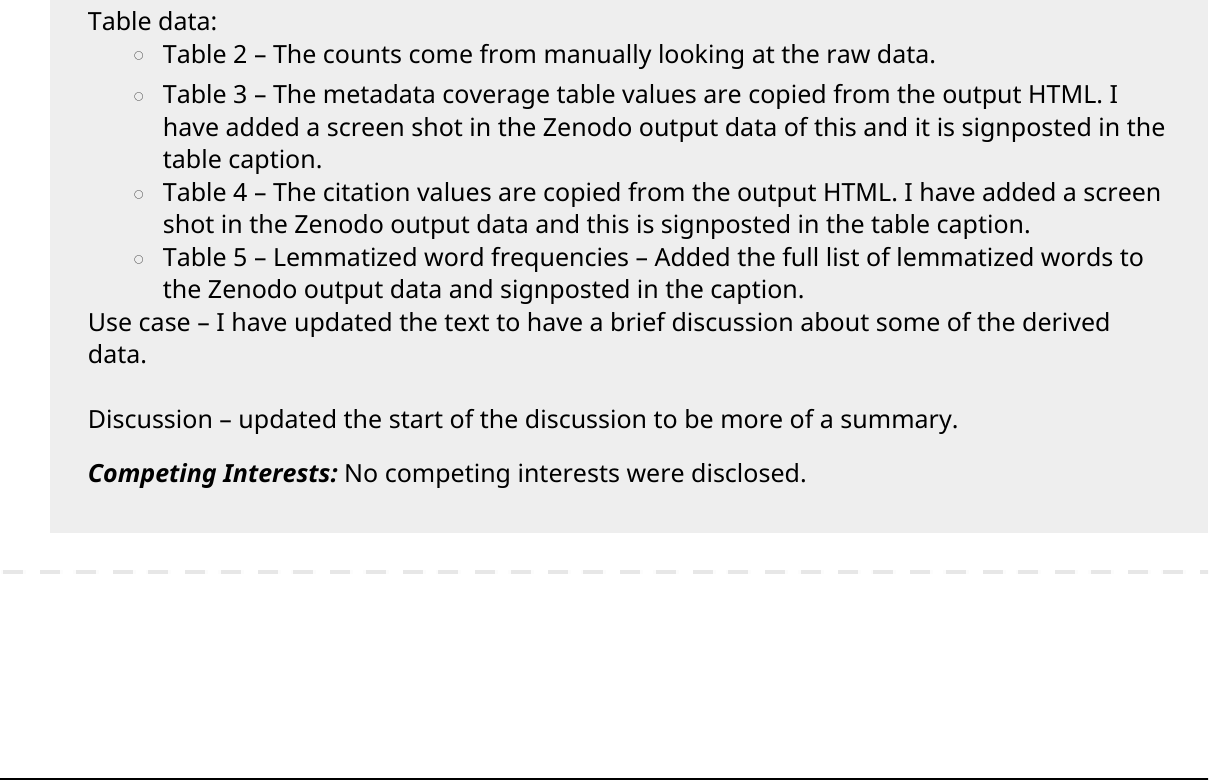
Table 2 – The counts come from manually looking at the raw data.